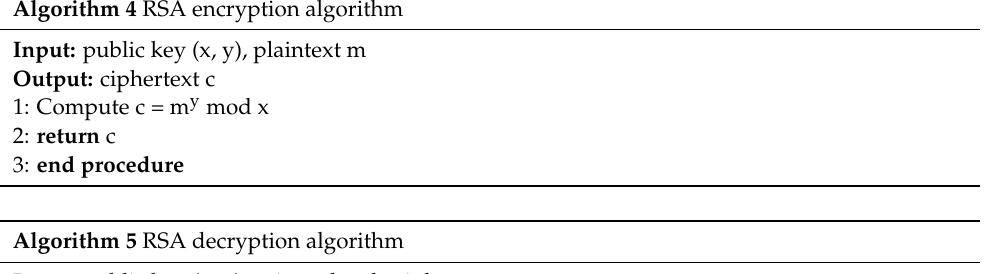
Algorithm 4 RSA encryption algorithm